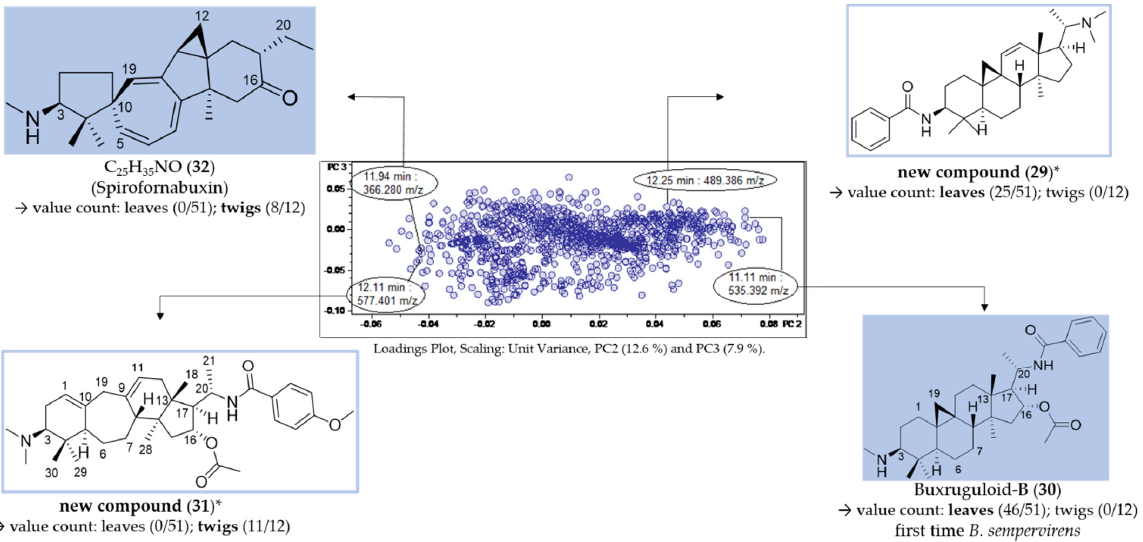
Figure 7. Assignment of unique features in the loadings plot of PC3 vs. PC2 (compare Figure 6B). * Structural assignment based only on mass spectral data; stereochemistry tentatively assumed in analogy with known compounds [3]. Table 3. LC/MS-characteristics of unique features (compare Figure 7). Cmpd.